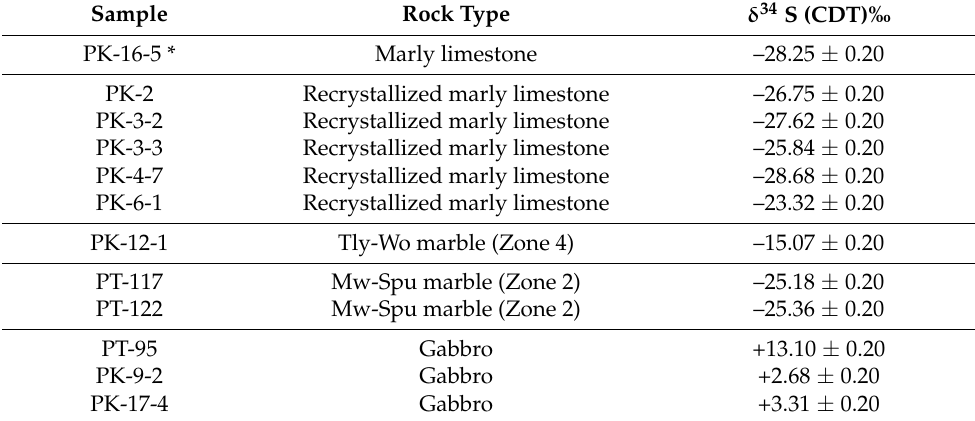
Table 12. Sulfur isotope compositions of pyrrhotite from recrystallized marly limestones and mar- bles from the Kochumdek contact aureole, and gabbro from the Kochumdek trap, compared with stratotype marly limestone of the Lower Kochumdek Sub-formation.